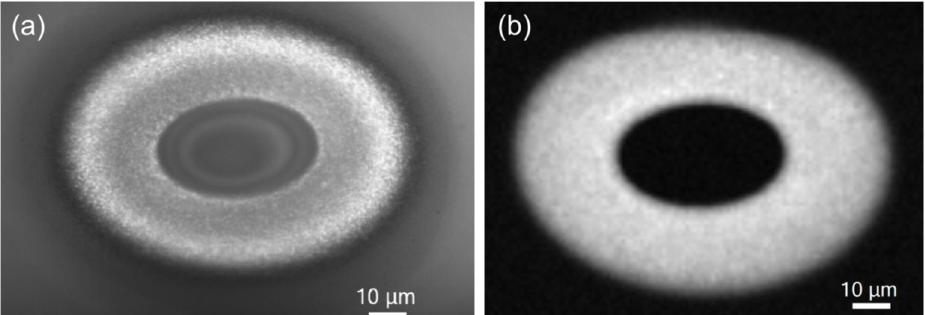
Figure 11. ( a ) Optical microscope photograph and ( b ) Raman map of the Si-nc band. A 2- μ m-thick free-standing SiO x film ( x ~ 1.7–1.8) is exposed to 488-nm light (~110